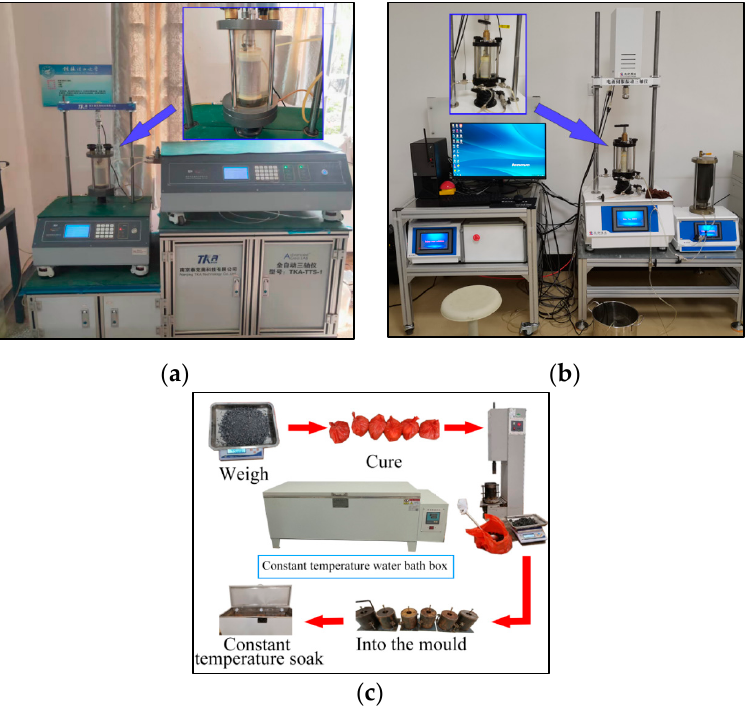
Figure 5. The experimental procedure of mechanical properties and deformation stability: ( a ) static triaxial test; ( b ) dynamic modulus test; ( c ) volume stability test. triaxial test; ( b ) dynamic modulus test; ( c ) volume stability